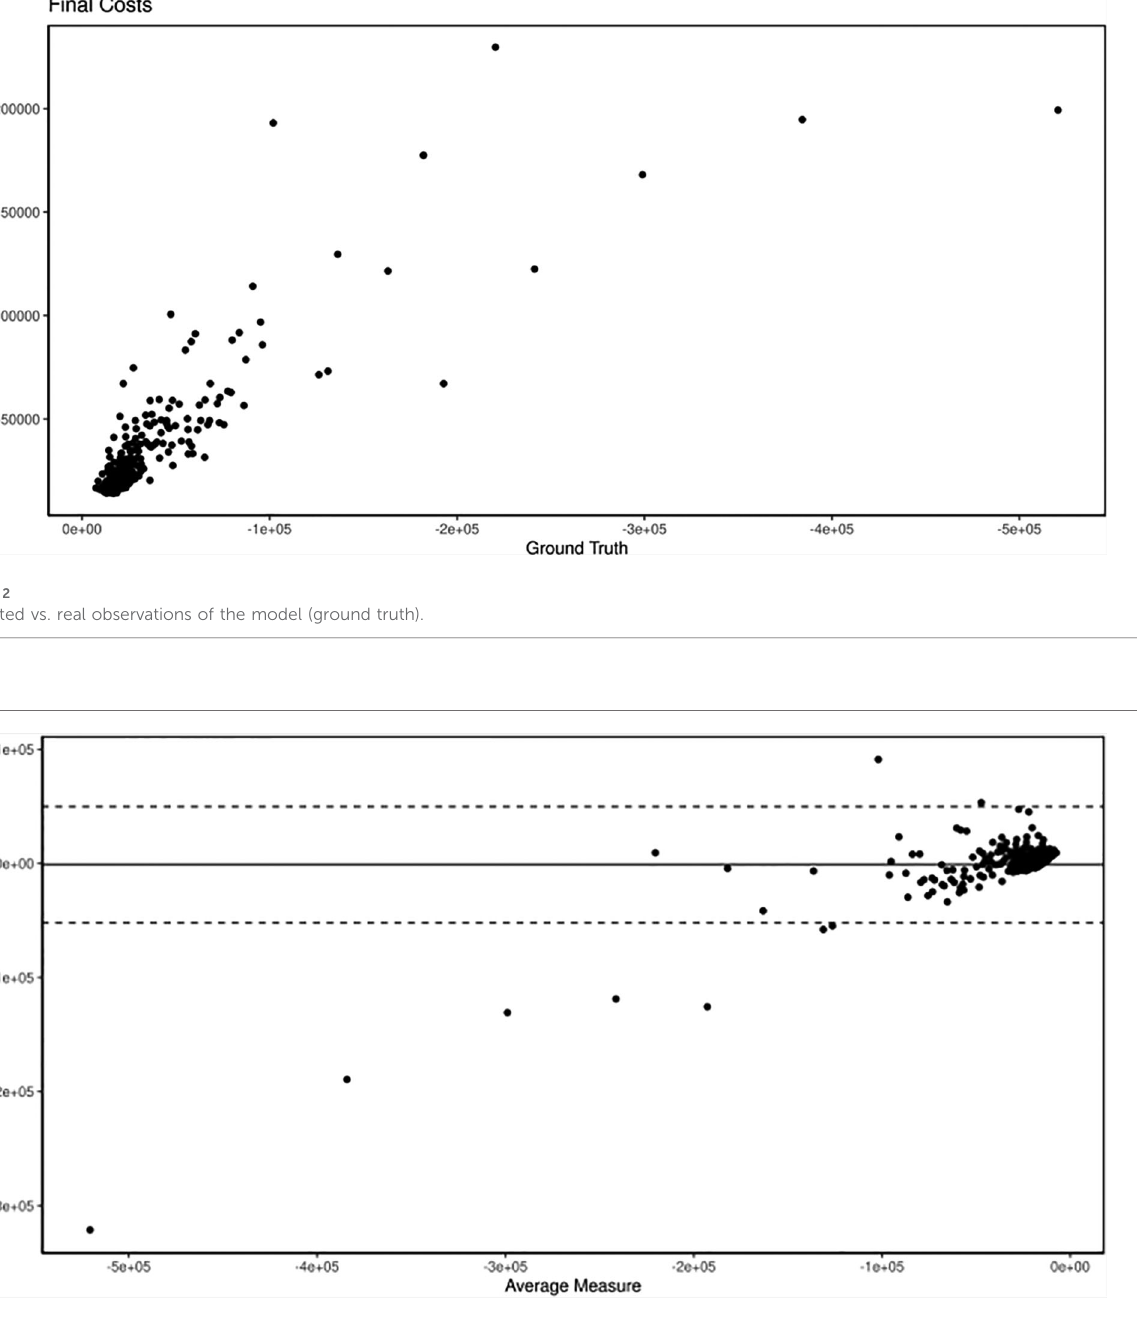
FIGURE 3 Bland – Altman plot, measured by the difference of both measured values ( S 1 – S 2) plotted on the y -axis against the mean value ( S 1+ S 2/2) on the x -